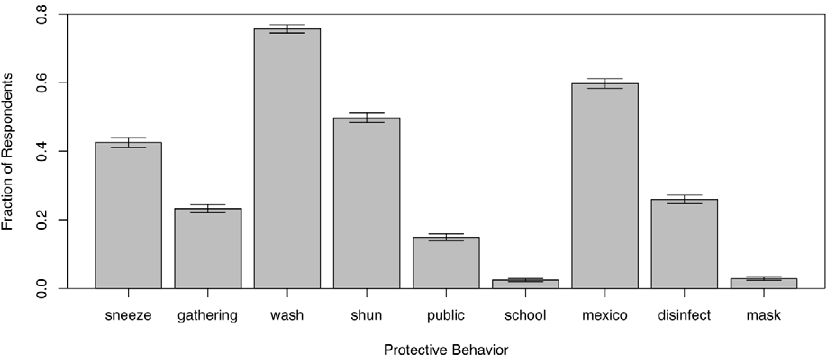
Figure 5. Frequency distribution of the protection measures undertaken by respondents. (‘‘sneeze’’=avoid people sneezing or coughing, ‘‘gathering’’=avoid large gatherings, ‘‘wash’’=wash hands more frequently, ‘‘shun’’=avoid people perceived to be sick and potentially infectious, ‘‘public’’=avoid public places, ‘‘school’’=stay home from school or work, ‘‘Mexico’’=avoid travel to affected foreign countries or states, ‘‘disinfectant’’=use alcohol-based disinfectant, ‘‘mask’’=wear a protective mask).